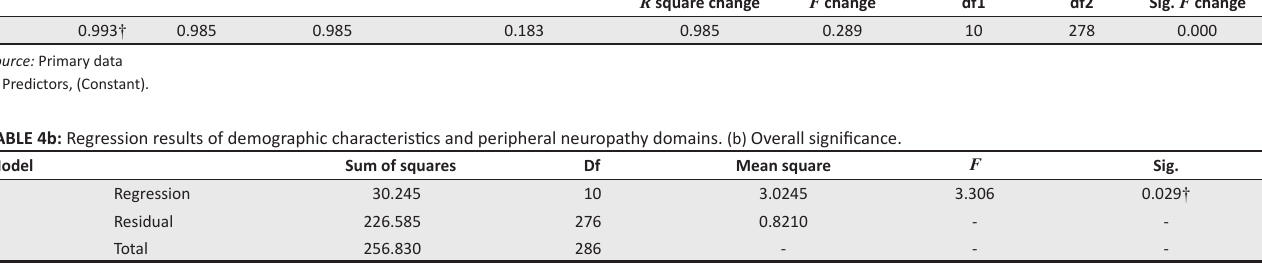
TABLE 4a: Regression results of demographic characteristics and peripheral neuropathy domains. (a) Goodness-of-fit. Model